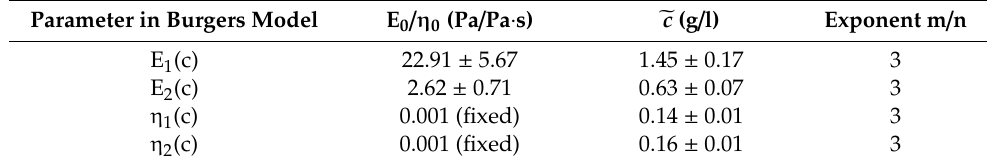
Table 5. Resulting fit parameters for fixed scaling exponents, according to Equations (15) and (16). Parameter in Burgers